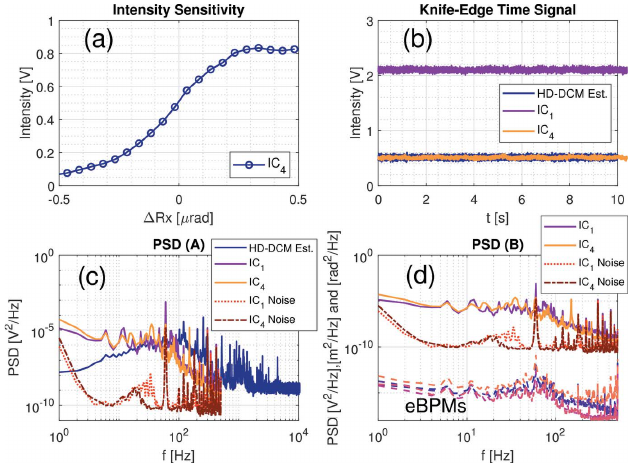
Figure 10 Knife-edge-based stability assessment with the HD-DCM: ( a ) second crystal pitch step-scan measurement for angle-to-intensity mapping using ionization chamber IC 4 ; ( b ) intensity measurement at maximum sensitivity point, with reference ionization chamber IC 1 , transmitted signal IC 4 and intensity variation estimate from the HD-DCM internal metrology; ( c ) power spectrum density (PSD) from the knife-edge measurement, including the HD-DCM estimate and IC noise floors; and ( d ) PSD from knife-edge measurements with electron beam position monitor (eBPM) data and IC noise floors. For further details see